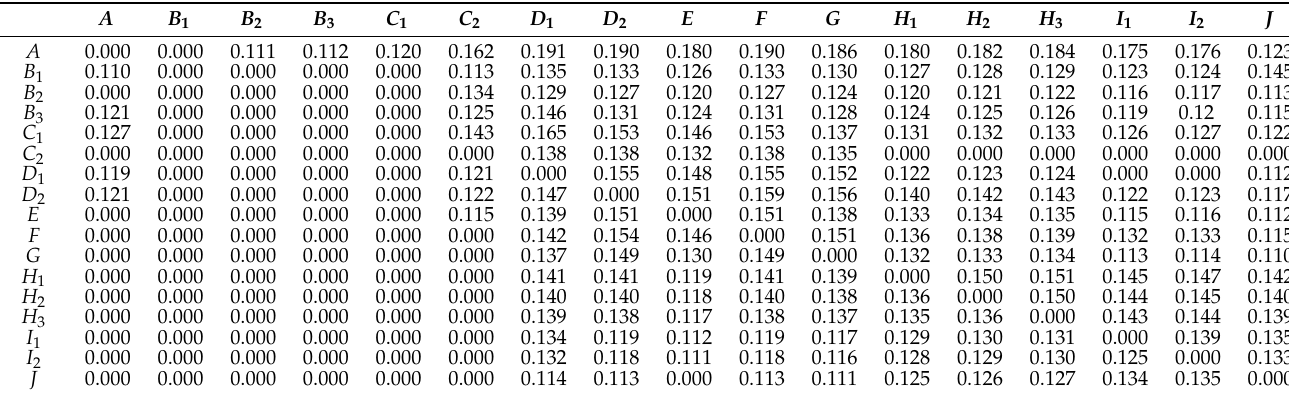
Table 5. Crisp total-relation matrix considering the threshold value.